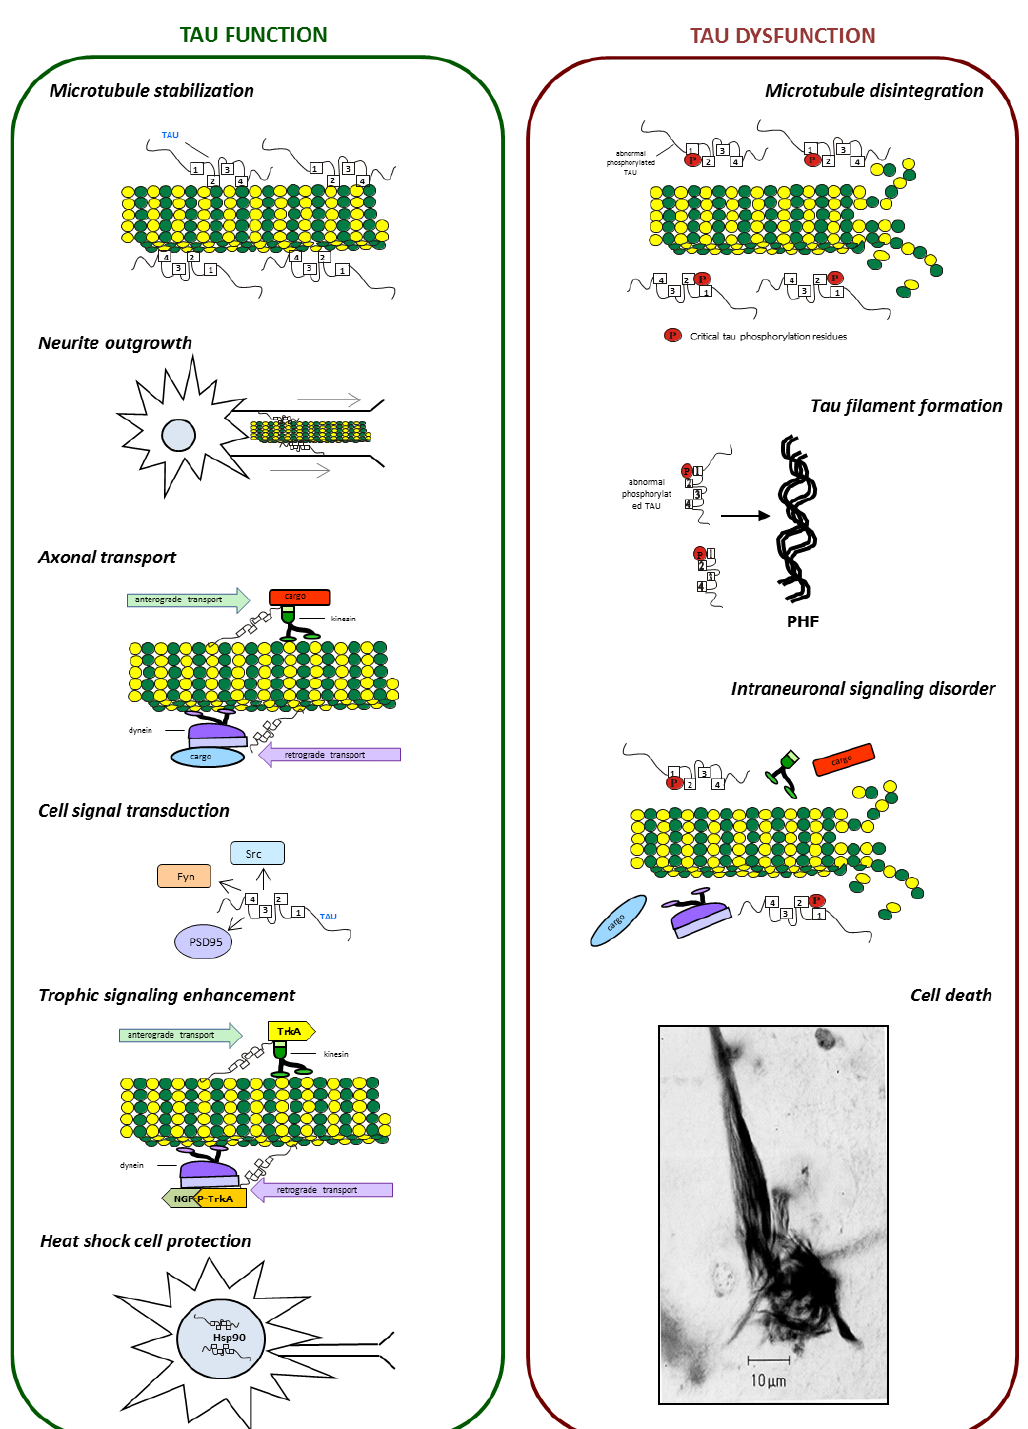
Figure 1. Tau is a multi-functional protein. As a microtubule-associated protein tau contributes to microtubule dynamics and participates in neurite outgrowth, axonal transport and trophic signaling enhancement. Moreover, tau participates in cell signal transduction through the modulation of the activity of Src and Fyn kinases and PSD95 protein. In the nucleolar organizing region of cell, tau can also be involved in DNA repair and heat shock responses ( left panel ). Tau dysfunction leads to microtubule disintegration, tau filaments formation and intraneuronal signaling disorder and, as a consequence, to cell death ( right panel